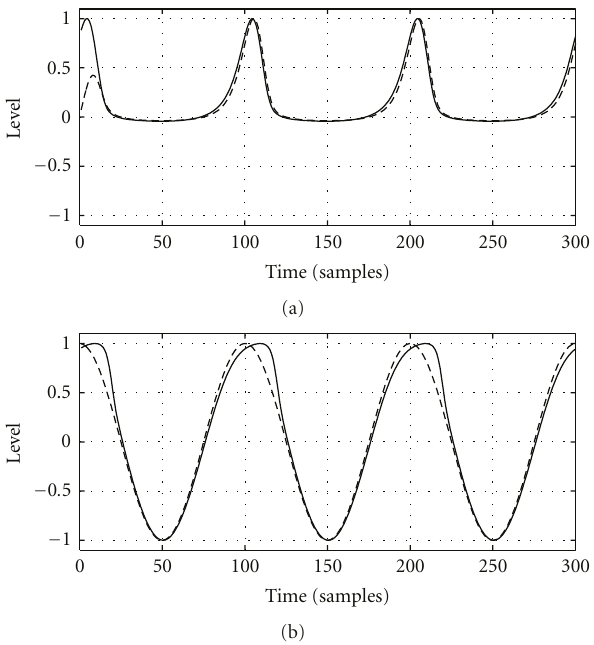
Figure 22: Waveform and spectrum of FBAM ( β = 1 . 62, dashed), PAF (bandwidth δ = 0 . 164, solid), and ModFM ( k = 25, dotted). Signals were generated with f c = f m =